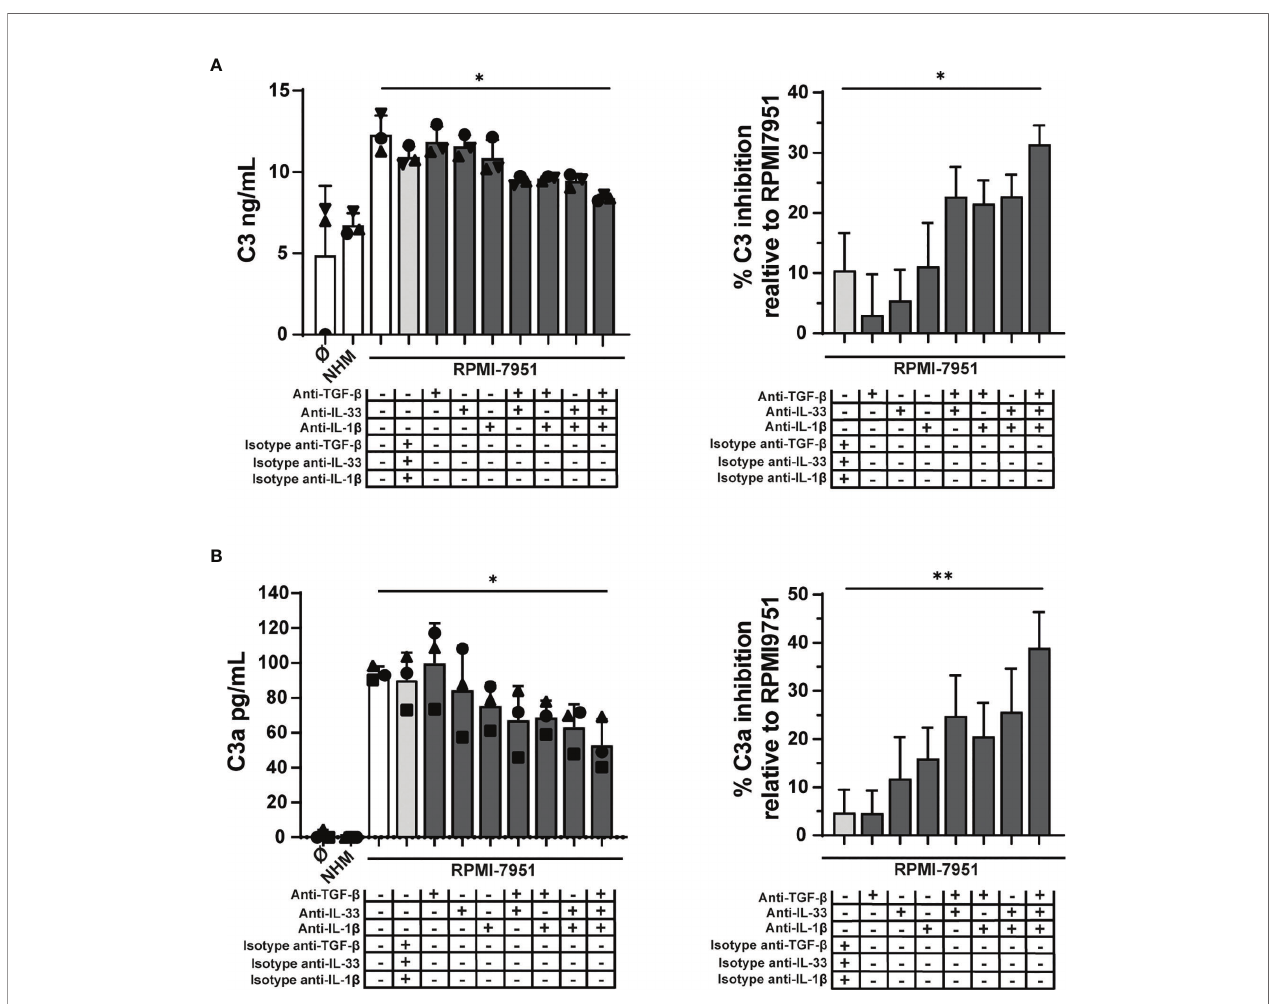
FIGURE 7 | Melanoma cell mediators regulate C3 in MCs. MCs were cultured for 48 h with RPMI-7951 melanoma cell culture supernatant, melanocyte cell culture supernatant (NHM), or with medium alone (Ø). Before treatment, MCs were incubated 30 min with different combinations of blocking antibodies, anti-human IL-33 (50 m g/ml), anti-human IL-1 b (50 m g/ml), anti-human TGF- b 1 (100 m g/ml), or appropriate isotype control antibody. In MC pellets, C3 (A) and C3a (B) were measured, respectively, by ELISA and CBA. Graphs on the right represent percent inhibition of C3 and C3a expression relative to protein levels in MC treated with RPMI-7951 melanoma cell culture supernatant alone. Data are shown as mean ± SEM of three independent experiments ( n = 3). One-way ANOVA statistical test was used; * p < 0.05, ** p <